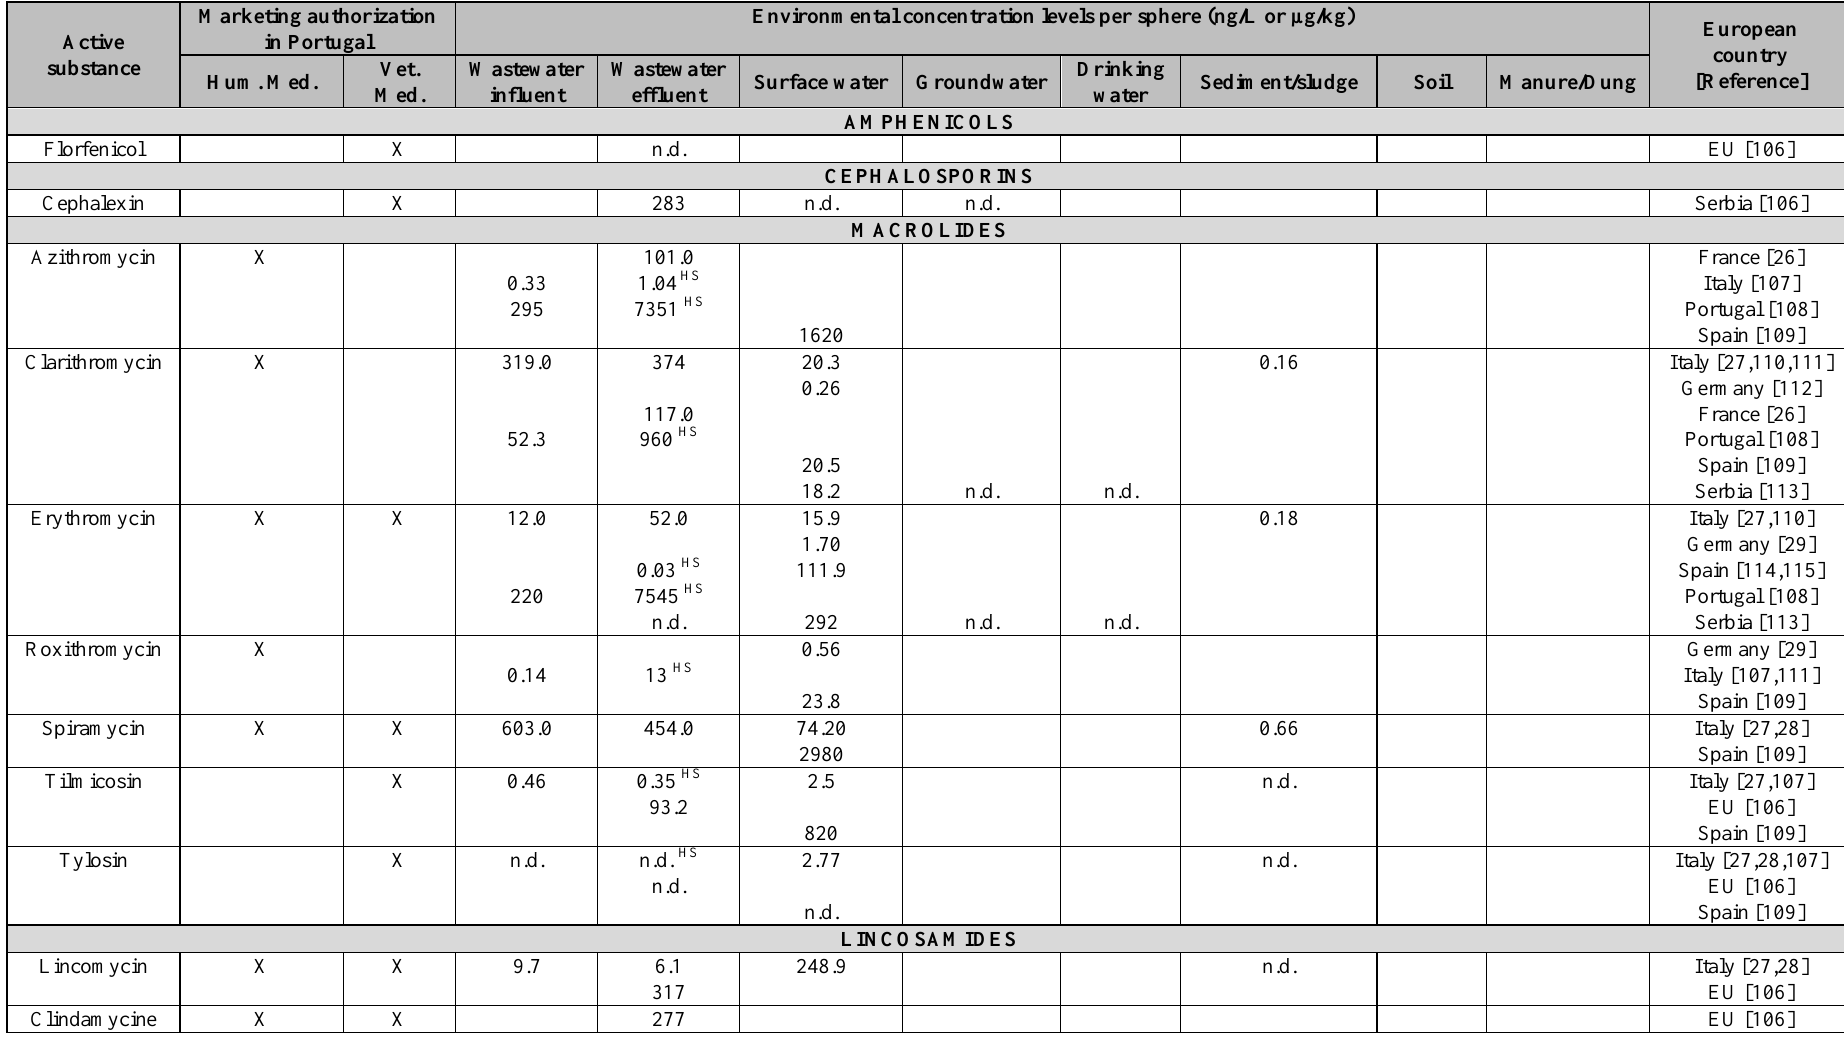
Table 3. Environmental concentrations levels (ng/L or µg/kg) of antibiotics most commonly used in Europe and Portugal according to recent literature. Only the highest values reported for each environmental compartment in each country were